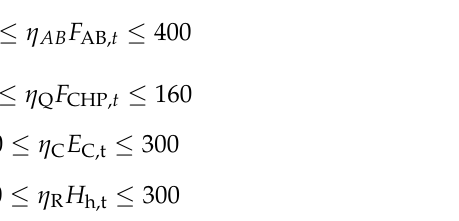
Figure 12. The hourly energy demands for regional end users.